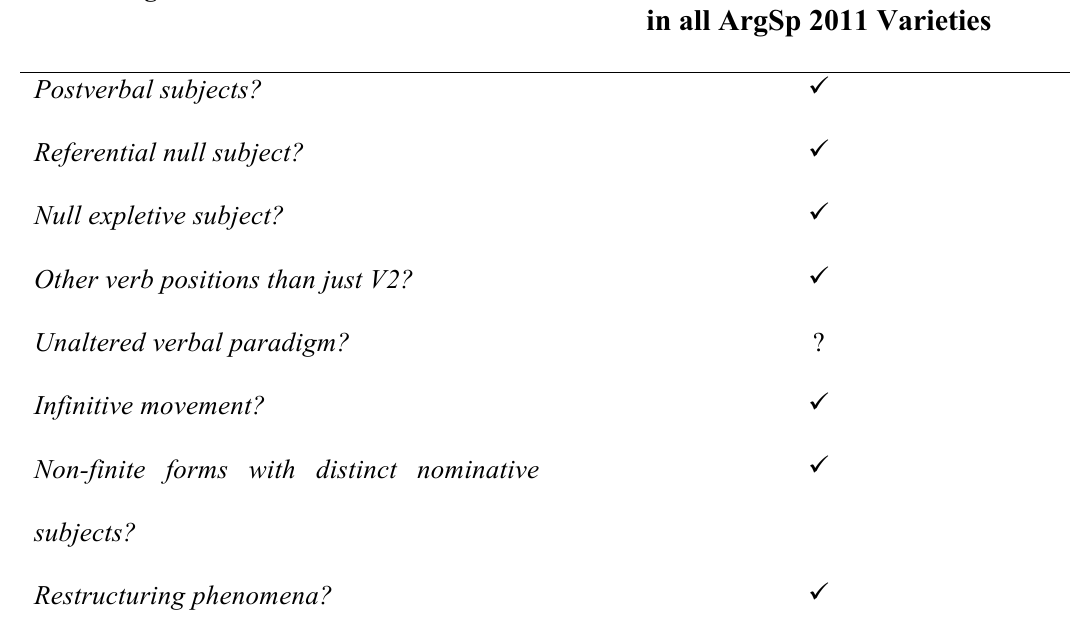
Table 4 . NSP cluster effects results for average of all ArgSp varieties tested in 2011 (Whimpanny